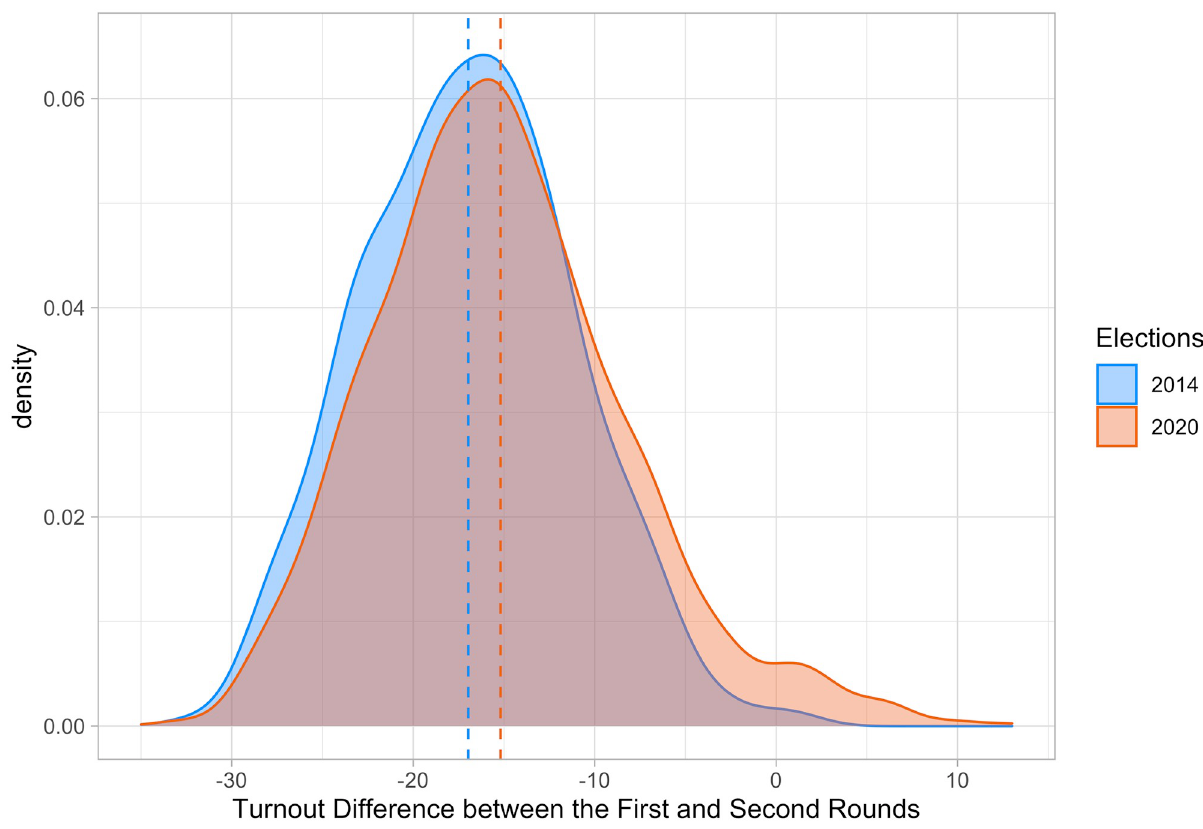
Fig 7. Distribution of turnout rate changes between the first and second rounds in the 2014 and 2020 elections.